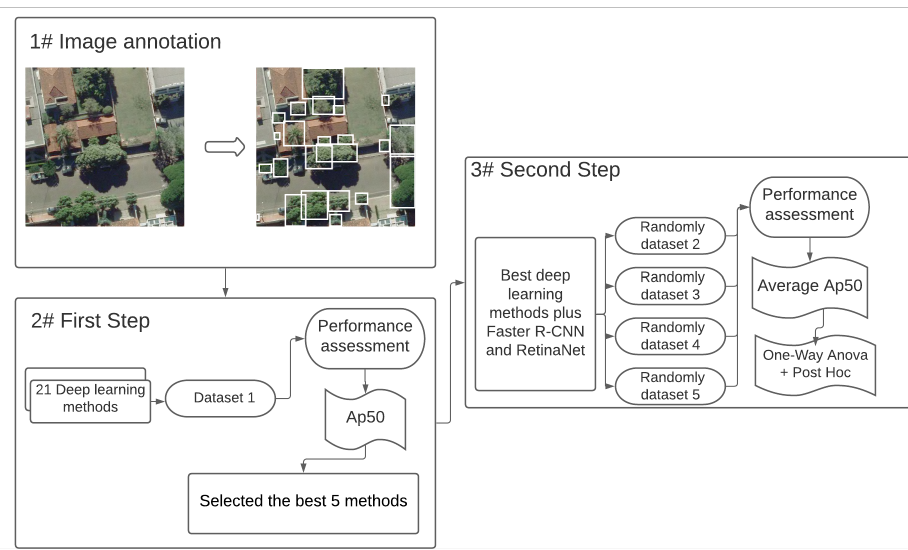
Figure 3. The workflow for individual tree crown detection. Initially, the images were annotated with bounding boxes. In the first step, 21 deep-learning methods were trained, and the best methods were selected based on the value of the third quartile plus Faster R-CNN and RetinaNet. In the second step, the selected methods were trained four more times with randomly shuffled